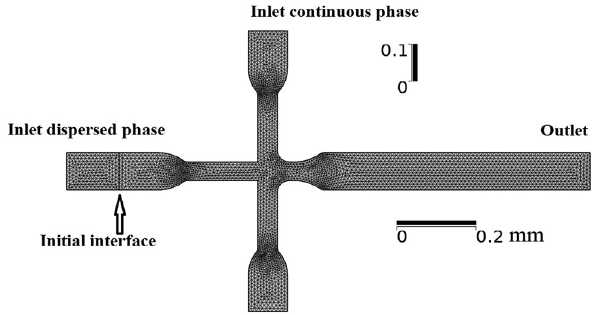
Figure 1: Schematic representation of the MFFD exploited in the simulation processes: 2D model of the de fi ned boundary conditions and meshes for the composite droplet